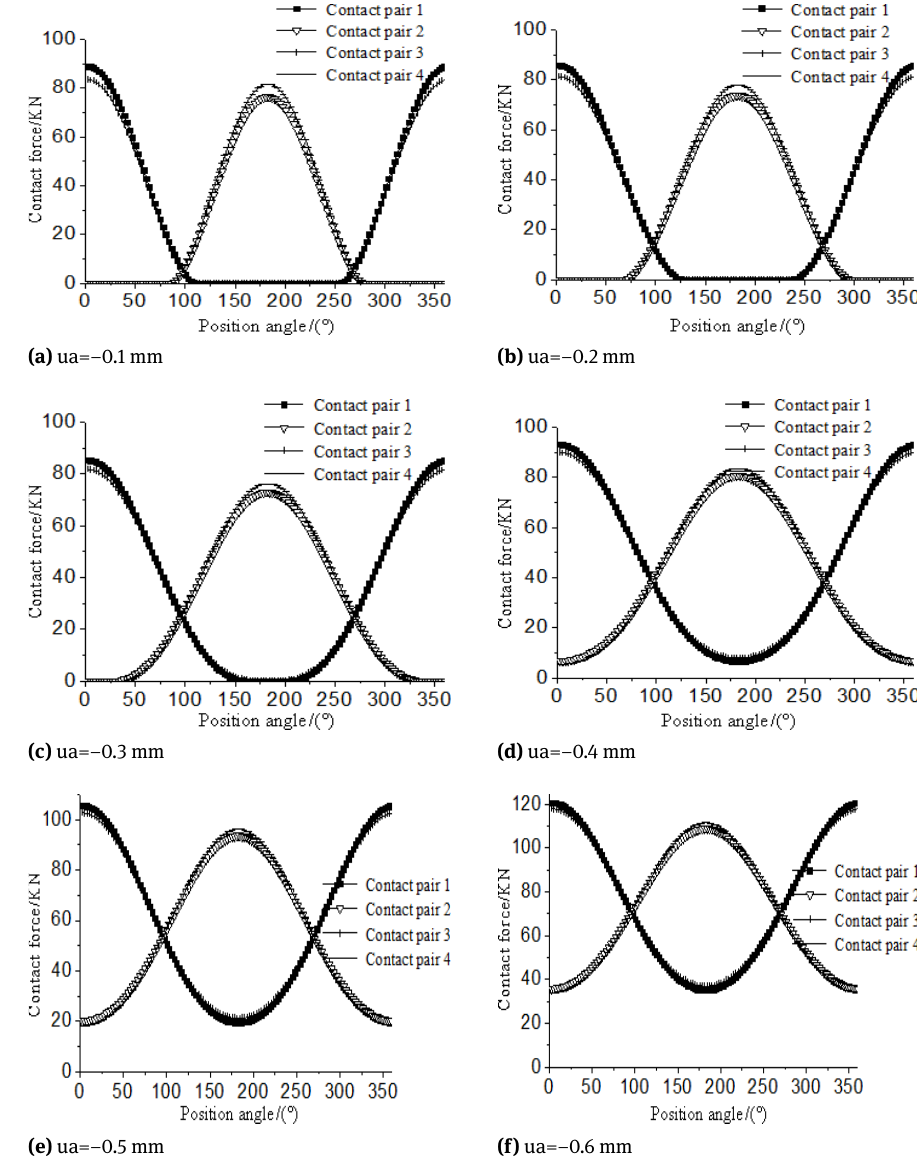
Figure 10: Contact force distribution with different